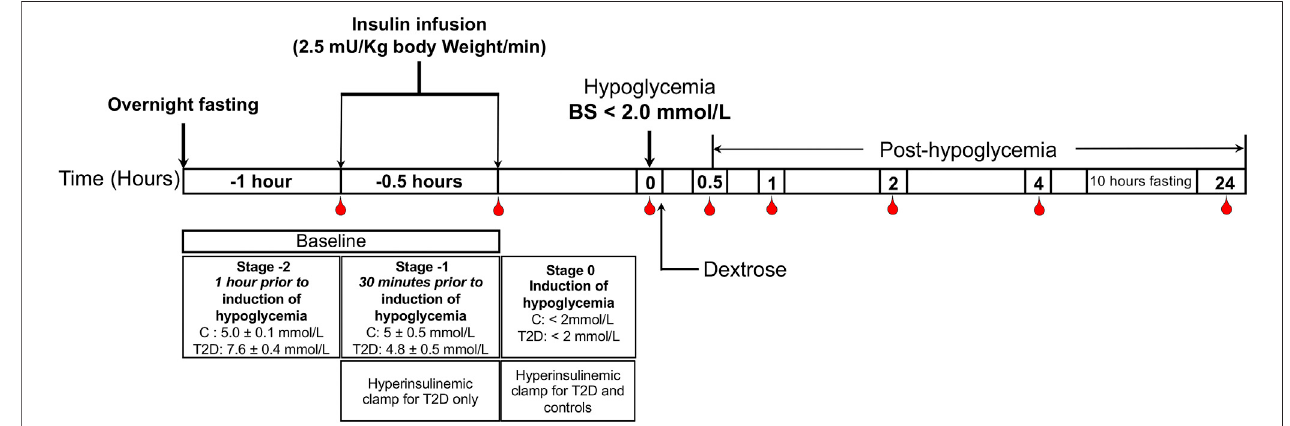
FIGURE 1 | Schematic diagram of the insulin clamp study. The schematic indicates the intervention and blood sampling time